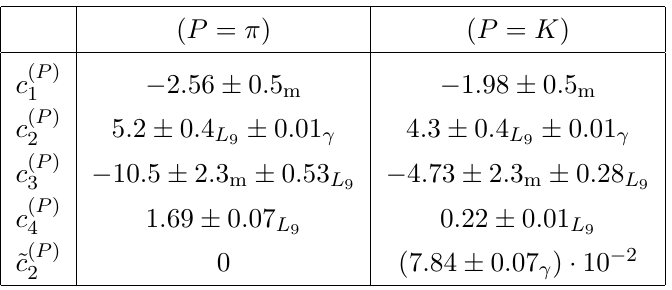
from ref. [59]). The uncertainties correspond Table 1 . Numerical values for c ( P ) n of (3.4) [12, 13] ( c ( P ) 1 to the input values L r ( µ = m ) = (6 . 9 ± 0 . 7) · 10 − 3 , γ = 0 . 465 ± 0 . 005 , and to the estimation of the ρ 9 counterterms ( m , from matching), affecting only c ( P ) and c ( P ) 1 3